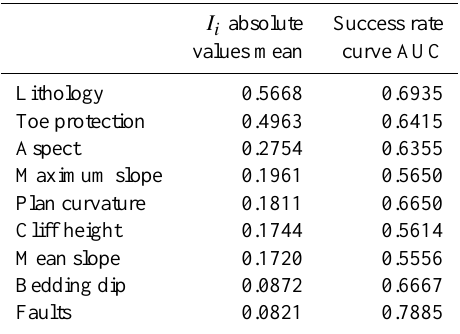
Table 3. Predisposing factors relevance based on I i